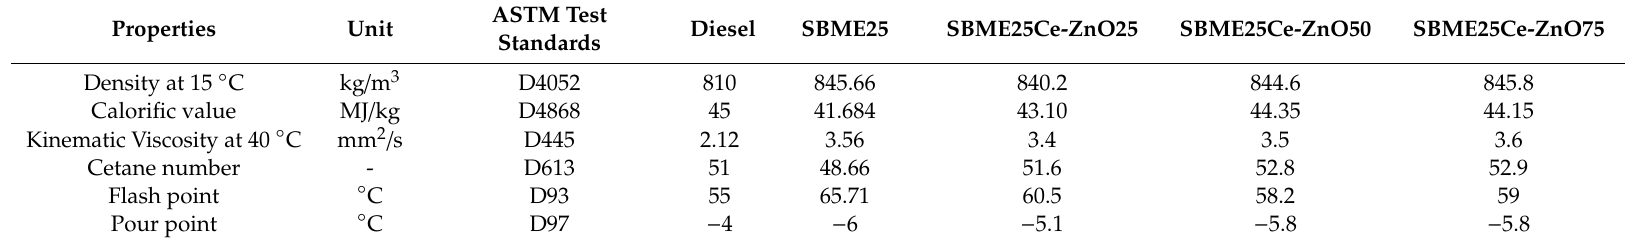
Table 4. Physicochemical properties of test fuels.